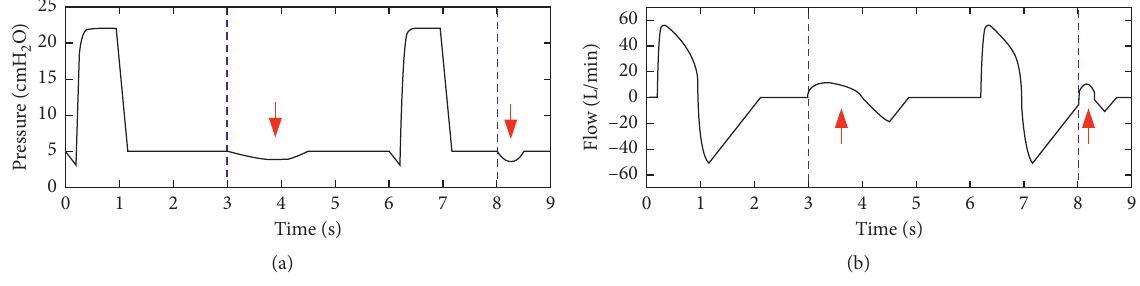
Figure 6: Ventilator waveforms of ineffective